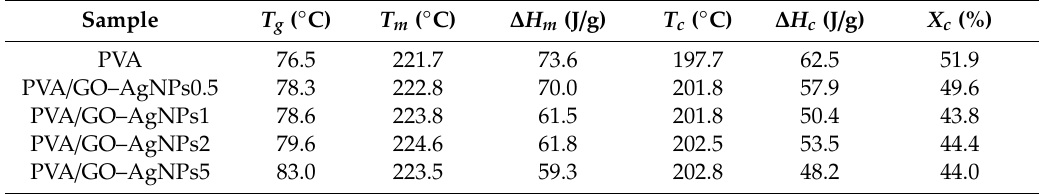
Table 2. Differential scanning calorimetry (DSC) results of neat PVA and PVA / GO–AgNPs nanocomposites.